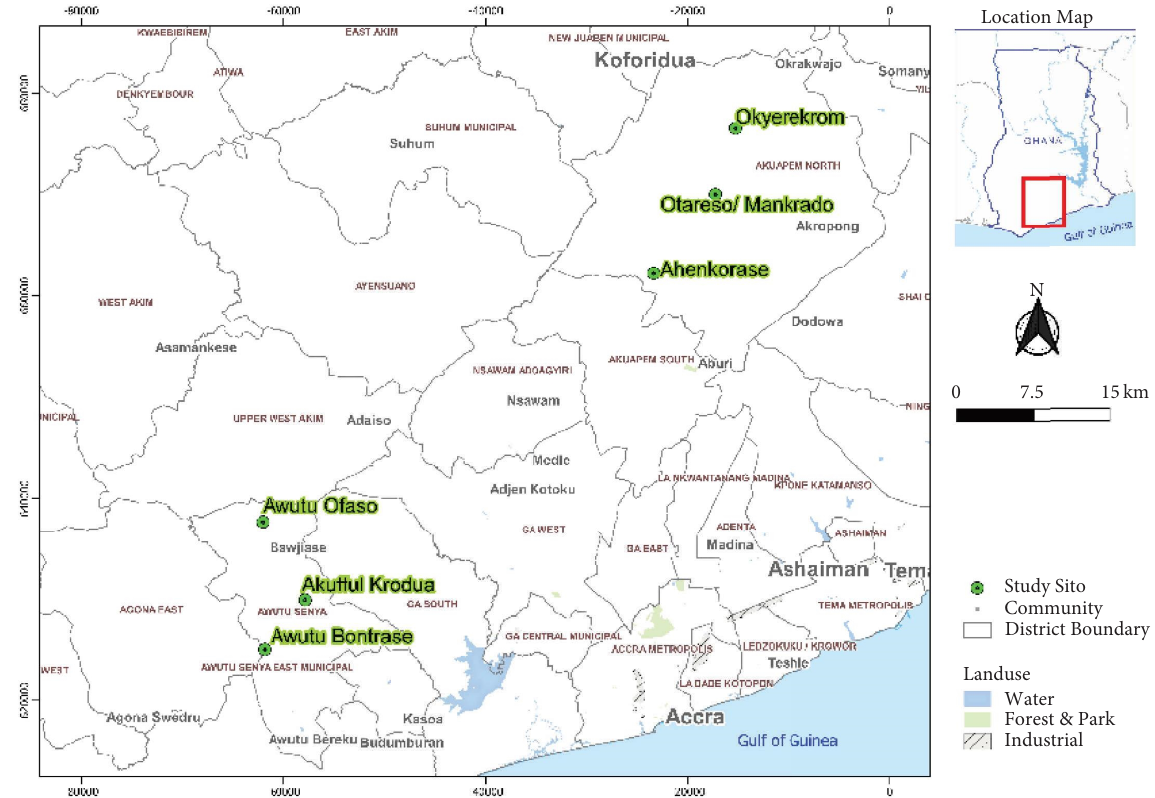
Figure 1: A section of the map of Ghana showing the study areas and the experimental sites in the coastal savannah and semi deciduous forest agroecological zones of Ghana. Table 1: Soil amendments and rates used in the major cropping season 2017. Soil